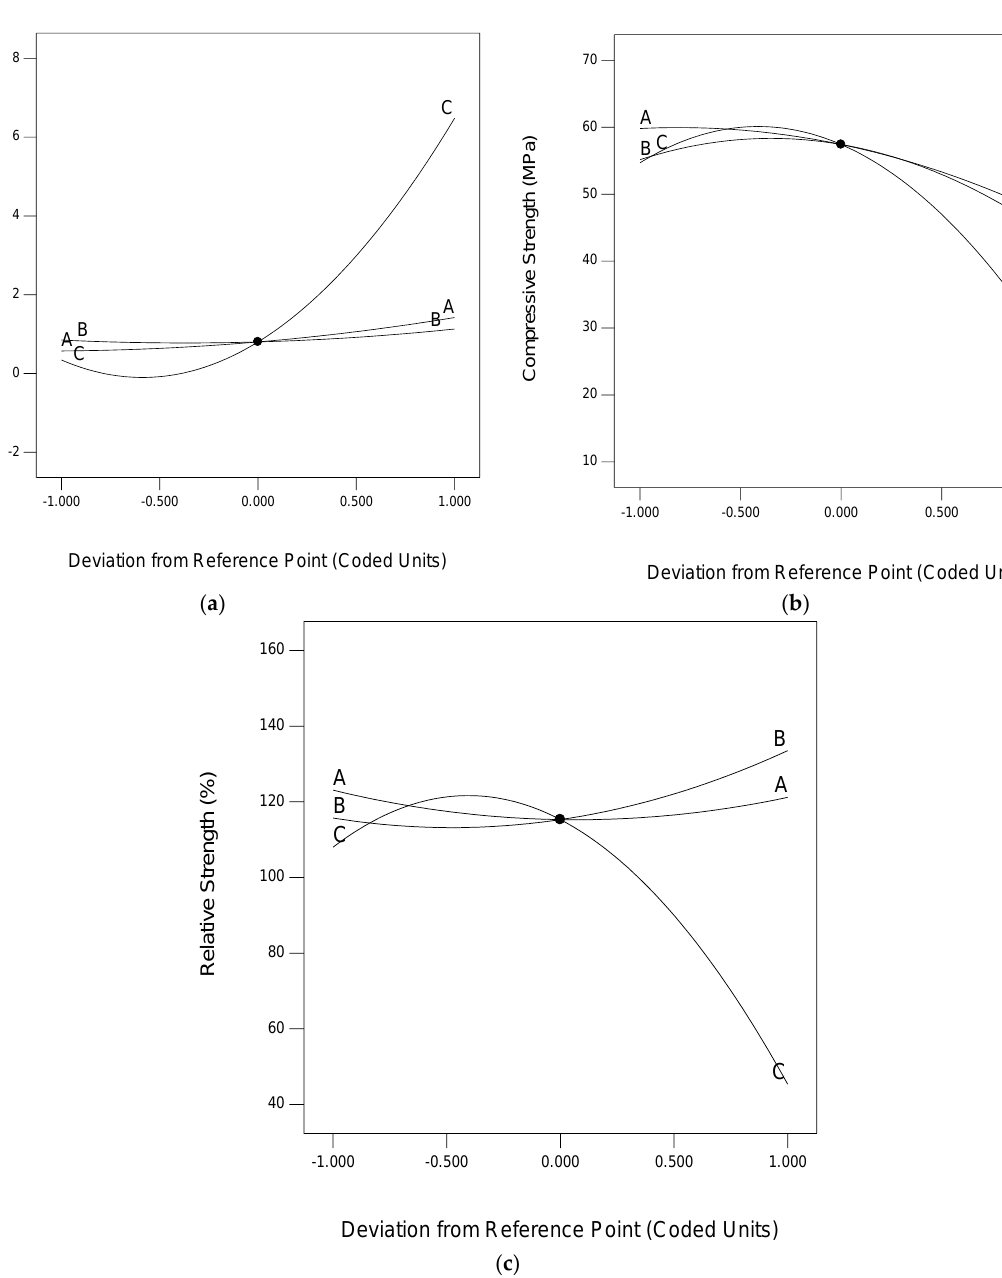
Figure 5. Perturbation plots. ( a ) Weight loss (%); ( b ) compressive strength (MPa); ( c ) relative strength (%).